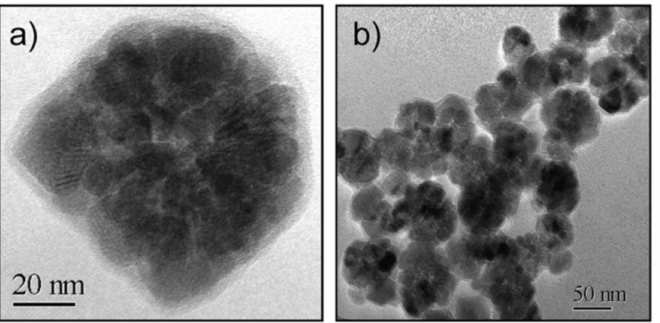
Figure 4. Typical TEM images of ( a ) a MC_NP consisting of exchange-coupled iron oxide cores and ( b ) an ensemble of MC_NPs. Reused with permission from Ref. [154], Copyright 2009 Elsevier B.V. All rights